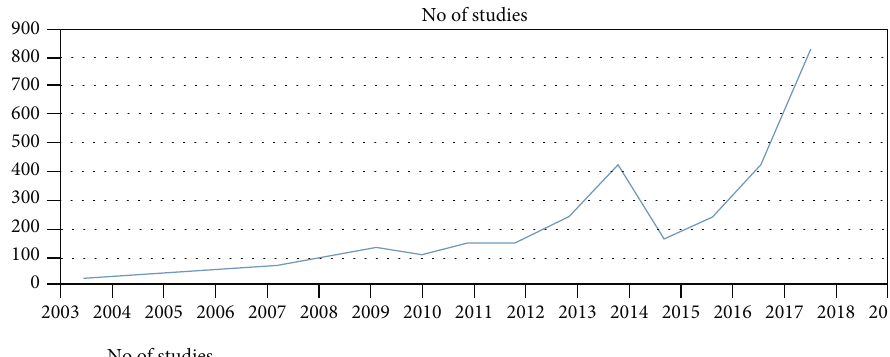
Figure 5: No. of studies regarding smart